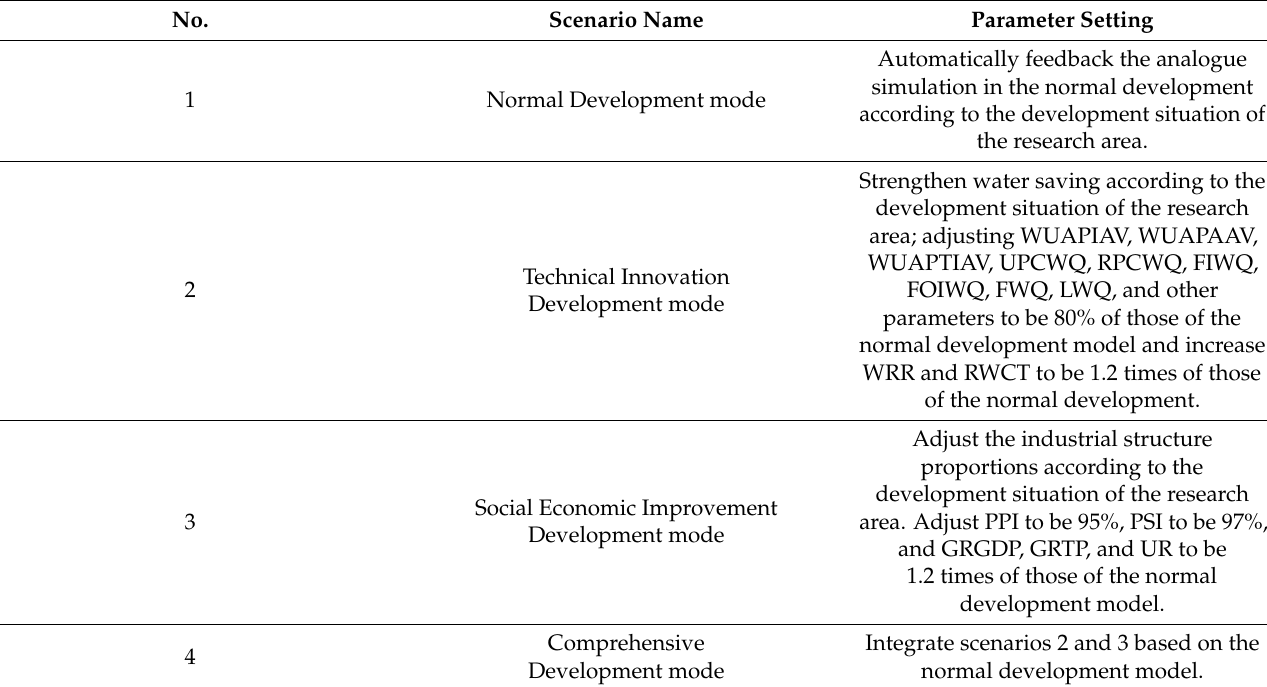
Table 4. Parameter setting schematics of the four different scenarios.